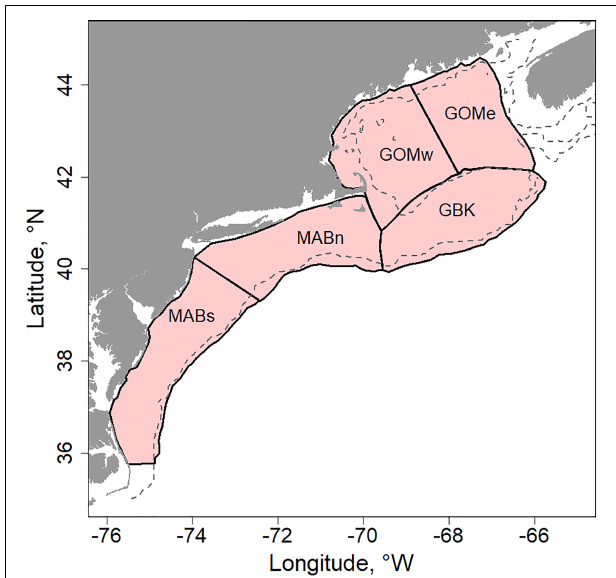
FIGURE 1 | US Northeast Shelf study area (NES) highlighted with shading and delimited to five subareas including: Georges Bank (GBK); Gulf of Maine east and west (GOMe and GOMw, respectively); and, Middle Atlantic Bight north and south (MABn and MABs, respectively), dashed line is the 100 m depth